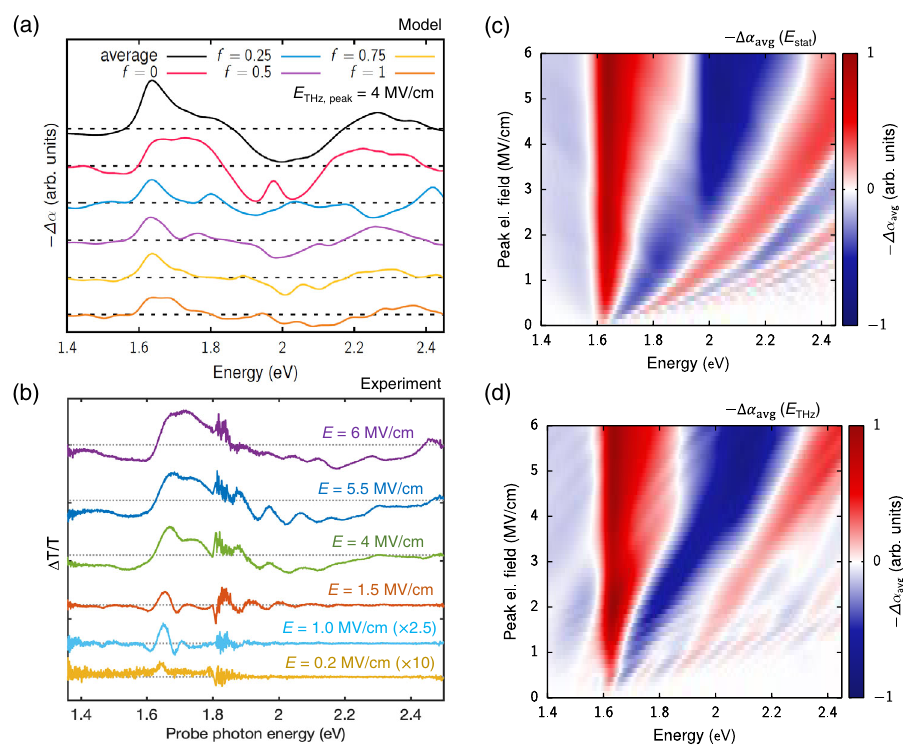
Fig. 4 Experiments on polycrystalline system and simulations with averaging of cosine band model from Γ Z to Γ Z direction. a Illustration for the averaging process over the interpolation parameter f from the Γ Z direction ( f = 0) to Γ A direction (f = 1). The negative absorption changes − Δ α f are calculated for different one-dimensional systems using a THz pulse centered at t = 0, with an amplitude of E 0 = 4 MV/cm, a pulse duration of (cid:1) T = 240 fs, and a THz center frequency of 20 THz. b Temporal slices of Δ T / T as a function of probe photon energy (Fig. 2a), at a delay time corresponding to the contour with constant electric- fi eld amplitudes E (Fig. 2b). c Averaged absorption change, − Δ α avg , for static fi elds of various strengths. d Averaged absorption change, − Δ α avg , for a THz pulse centered at t = 0 and various fi eld parameter f . The simulated absorption changes at a fi eld ampli- tude of E 0 = 4 MV/cm with various interpolation parameters f are different instantaneous fi eld amplitudes of the THz pulse (i.e., the c axis) and f = 1 along the Γ A direction.